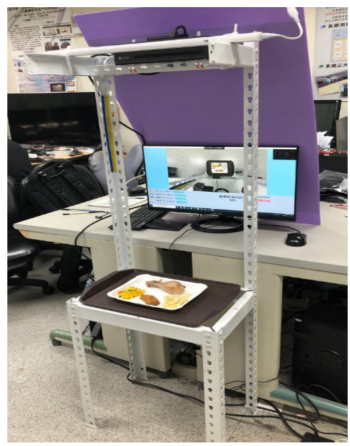
Figure 2. The proposed prototype for food recognition and